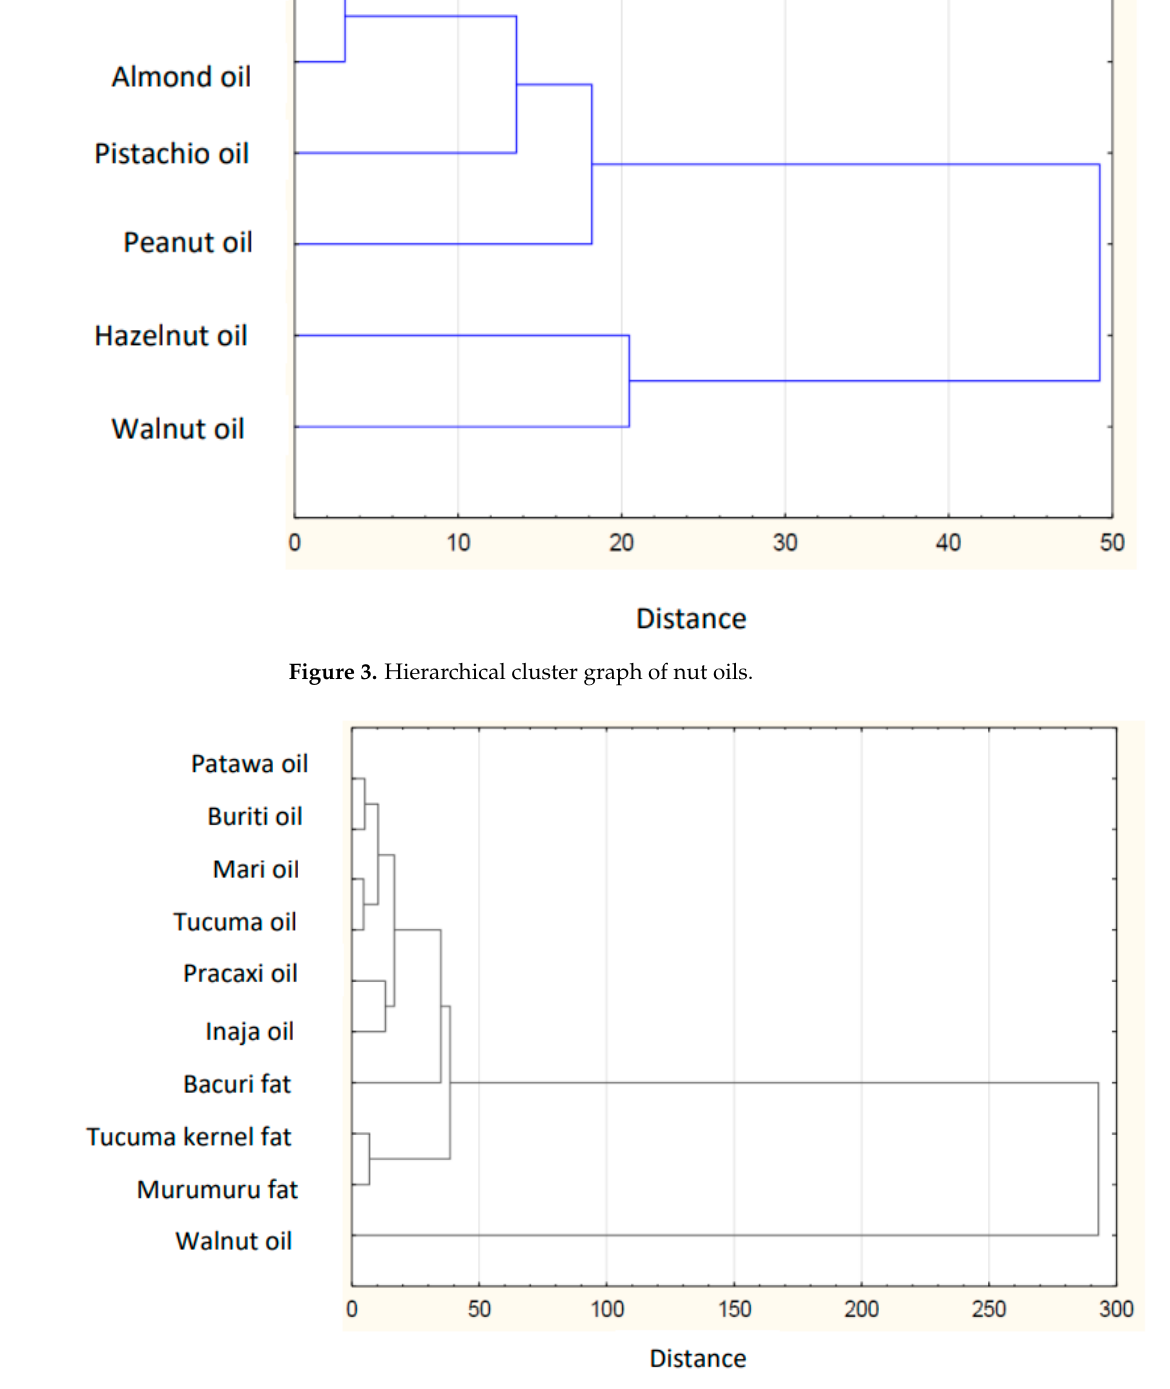
Figure 4. Hierarchical cluster graph of Amazonian fats and oils.